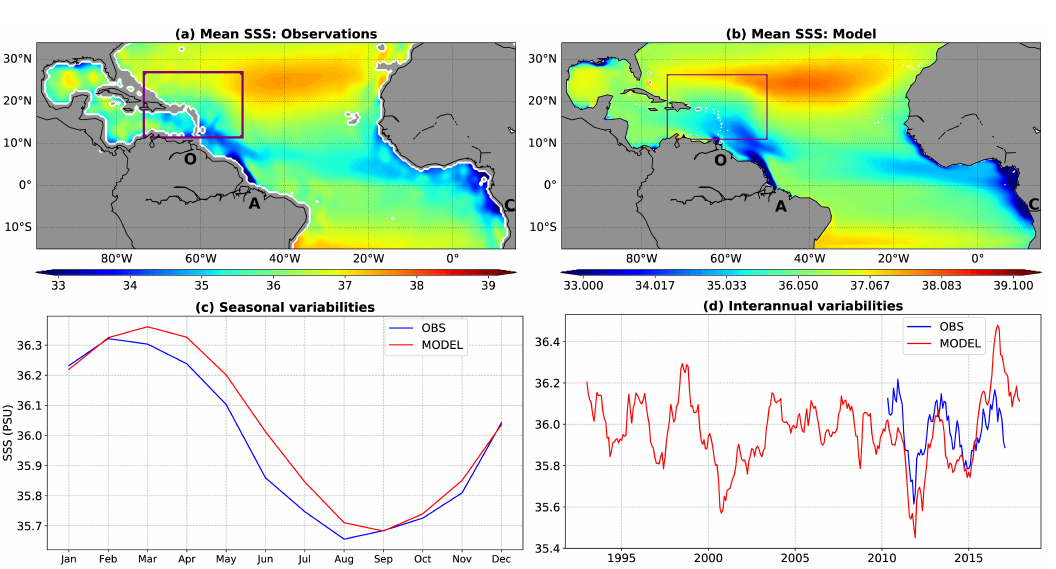
Figure 3. Time-mean SSS from SMOS satellite ( a ) and from model ( b ). Low-salinity plumes of Orinoco river (O), Amazon river (A) and Congo river (C) are visible. Seasonal ( c ) and interannual ( d ) variability of SSS averaged from 50° W to 74° W and from 11° N to 26° N (purple rectangle shown in a and b). Units are in PSU. The considered period for time-mean and seasonal cycle is